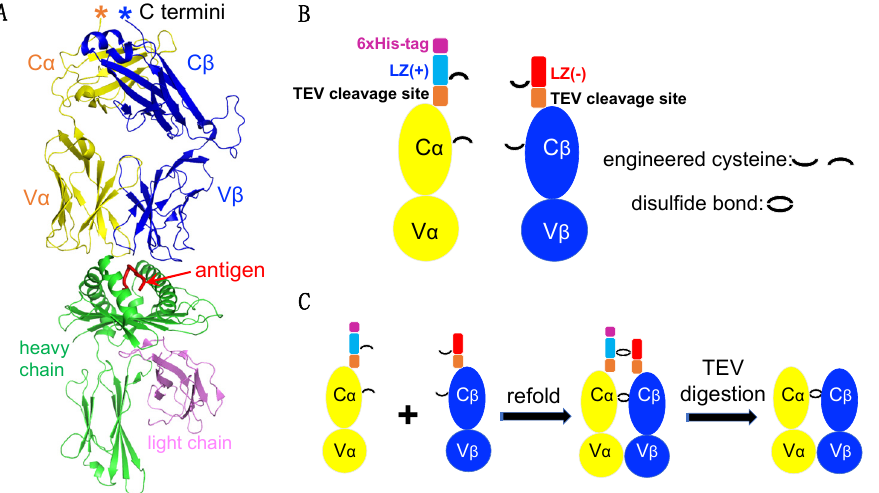
Figure 1. TCR αβ heterodimer construct design. ( A ) Overall structure of a representative TCR αβ -pMHC complex (PDB code: 1OGA). ( B ) Architectures of the engineered TCR α and TCR β . ( C ) Schematic diagram depicting TCR αβ dimerization and TEV protease digestion.